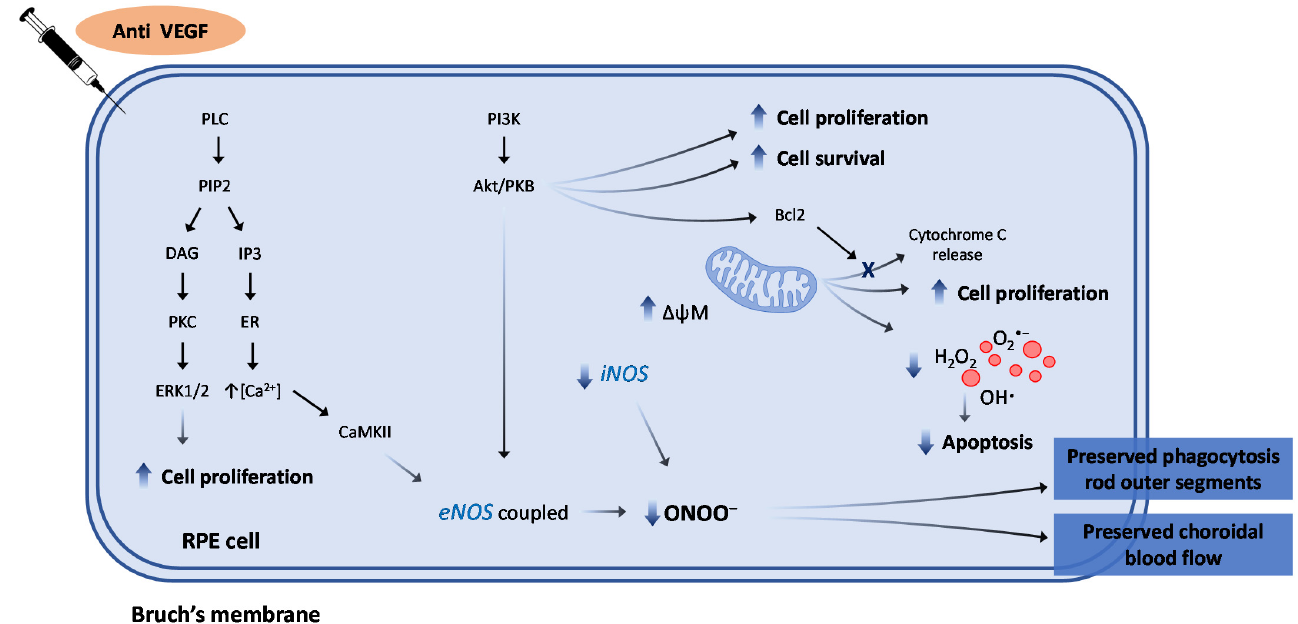
Figure 5. Schematic representation of the intracellular pathways activated by anti-VEGF agents in AMD. PLC: phospholipase C; PIP2: phosphatidylinositol 4,5-bisphosphate; DAG: diacyl glycerol; IP3: inositol triphosphate; PKC: protein kinase C; ER: endoplasmic reticulum; PI3K: phosphoinositide 3-kinase; PKB: protein kinase B; ERK1/2: extracellular signal-regulated kinase 1/2; CaMKII: calcium/calmodulin-dependent protein kinase II; eNOS: endothelial nitric oxide synthase isoform; iNOS: inducible nitric oxide synthase; ONOO − : peroxinitrites; Δψ M: mitochondrial membrane potential.